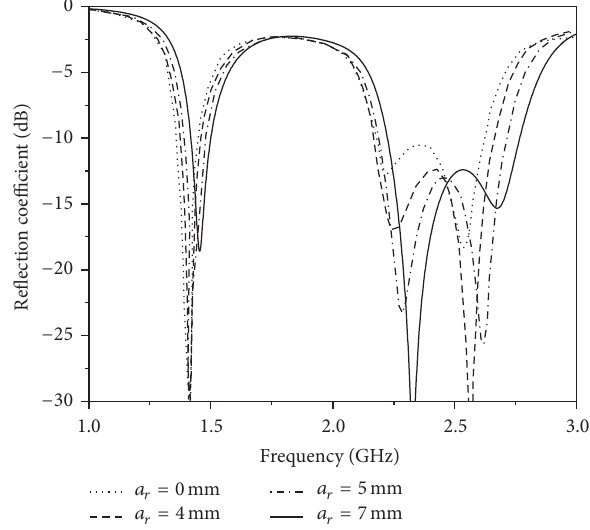
Figure 7: Simulated reflection coefficient for different values of the cylindrical air gap radius 𝑎 𝑟